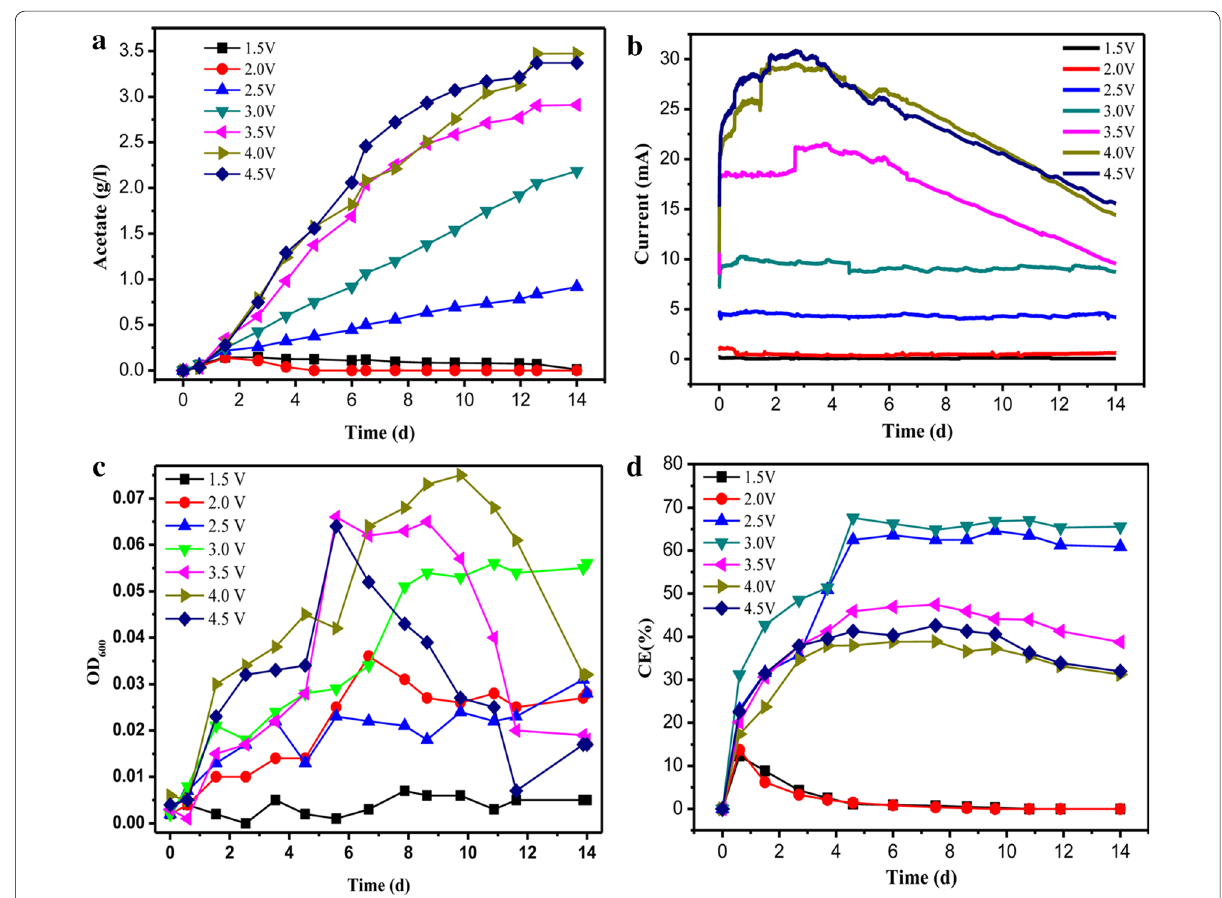
Fig. 1 Effect of applied cell voltage on the MES performance in terms of a acetate production, b current, c OD 600 , and d